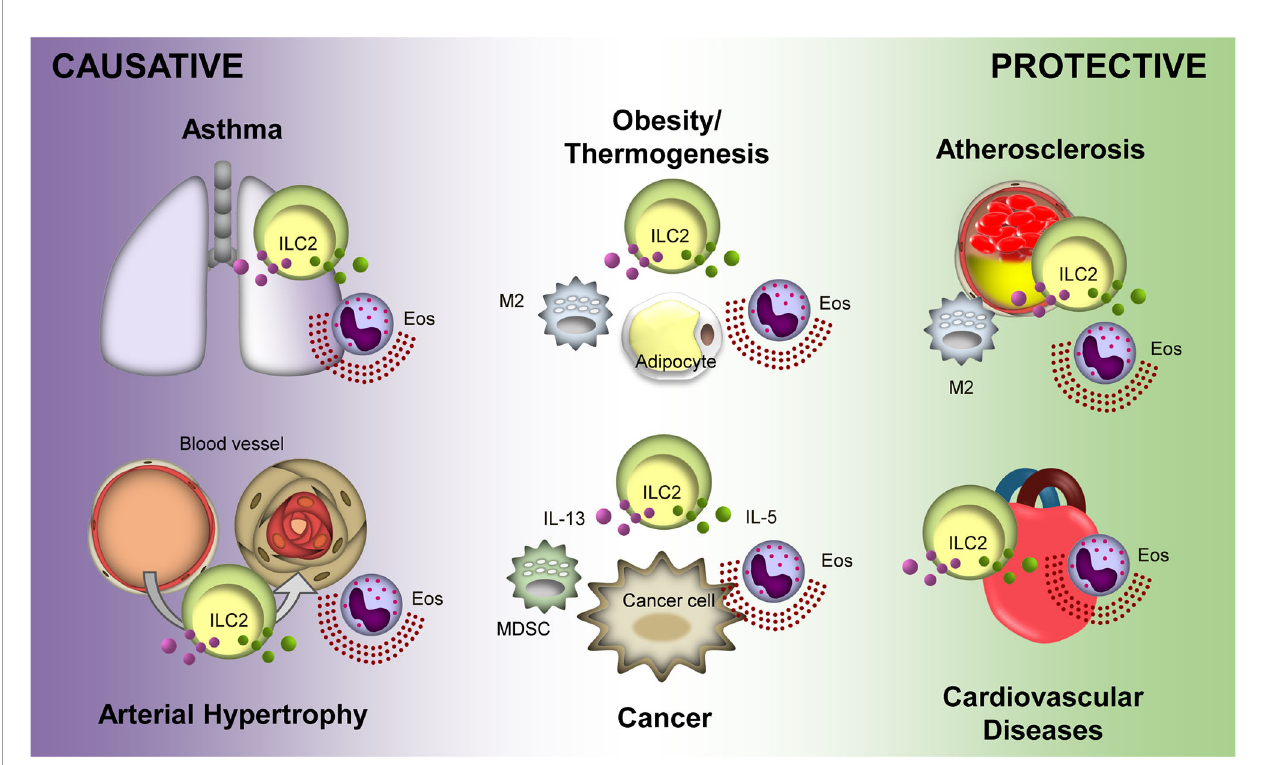
FIGURE 1 | Protective and causative roles of Group 2 Innate Lymphoid Cells (ILC2s) in different diseases. ILC2s display a protective role in atherosclerosis and cardiovascular diseases. Overall, ILC2s is protective in obesity and thermogenesis; however, distal ILC2s may cause obesity. Conversely, ILC2s potentiate asthma and arterial hypertrophy. Their roles in cancer are varied depending on the tumor microenvironment and type of cancer. Purple and green particles depicted in the fi gure are interluekin-13 (IL-13) and IL-5, respectively. Eos, eosinophil; M2, M2 macrophage; MDSC, myeloid-derived supressor